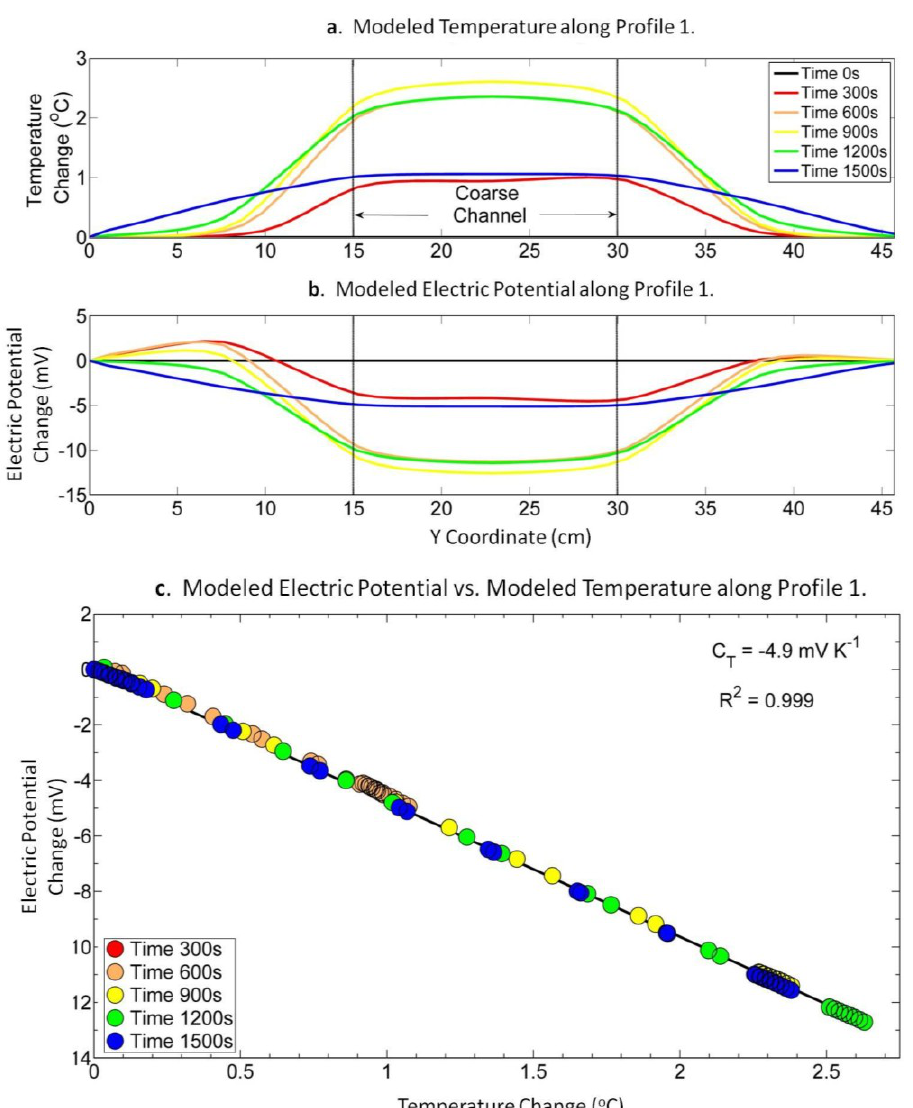
Figure 6. Simulated temperature and electric potential changes relative to background along Profile 1 (see position in Figure 5) following the injection of hot water in an upstream reservoir. ( a ) Simulated temperature change relative to background. The temperature anomaly is confined primarily to the permeable channel; ( b ) Simulated electric potential change relative to background following the hot injection. The electric potential anomaly is negative, achieves a peak amplitude of approximately −13 mV, and is confined primarily to the permeable channel; ( c ) Simulated relationship between temperature change and electric potential change along profile 1. The relationship is linear and has a slope of −4.9 mV·K −1 , which is approximately equivalent to the thermo-electric (intrinsic) coupling coefficient of C = −5 mV·K −1 incorporated into the model, indicating the potential anomaly T is due to the temperature change in the tank for this simulation (modified after